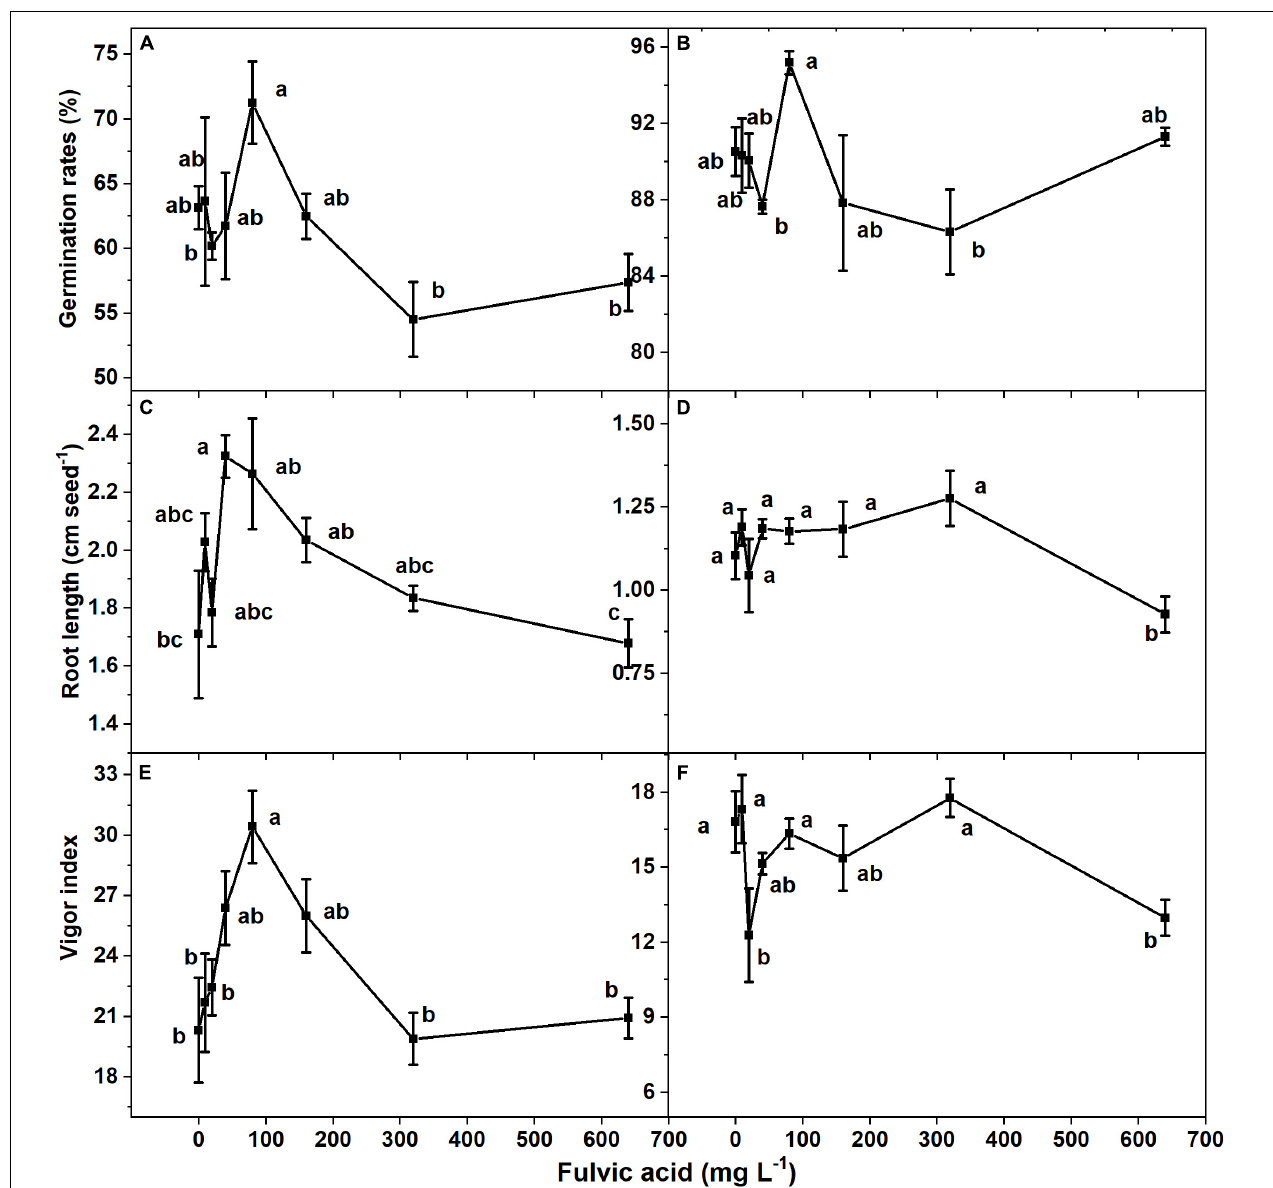
FIGURE 3 | The effect of fulvic acids on the germination rate, root length, and vigor index in of tomato seeds cv. Huangmeiren (A,C,E) and cv. Zizhenzhu (B,D,F) germinated for 7 days. Data are means ± s.e ( N = 3). The same letters denote insignificant differences ( P < 0.05) among treatments according to Duncan’s new multiple range test (Experiment